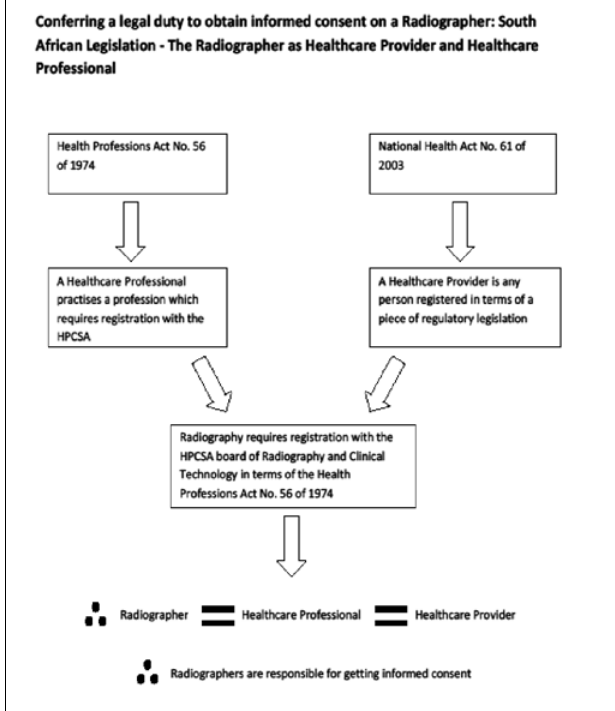
Fig. 1. The diagram depicts the interaction of South African legislation that pertains to informed consent and radiographers. It shows how certain legislative documents link together to ultimately confer a legal duty to obtain informed consent on radiographers (as well as all other healthcare